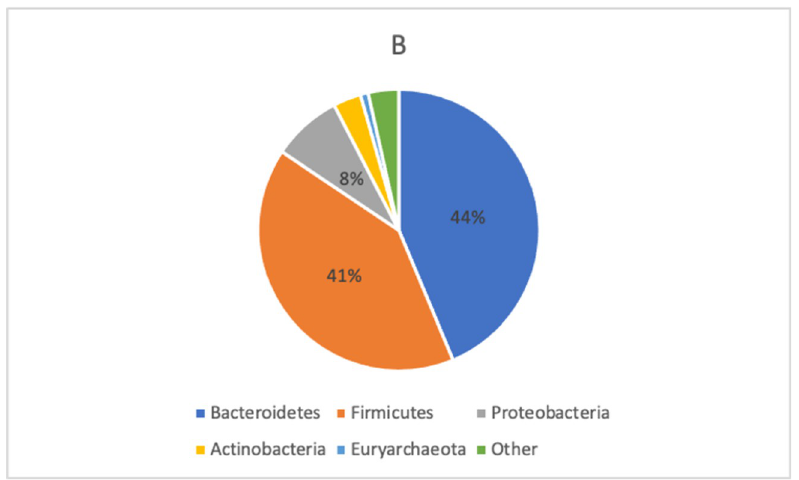
Fig 3. Taxonomic composition of bacterial phyla in healthy controls. For healthy controls, the predominant phyla were Bacteroidetes (44%), Firmicutes (41%) and Proteobacteria (8%). All phyla were tested for differences with DeSeq2 (GMPR normalization) which did not reveal any significant results. Abbreviations: gmpr–geometric mean of pairwise ratios.